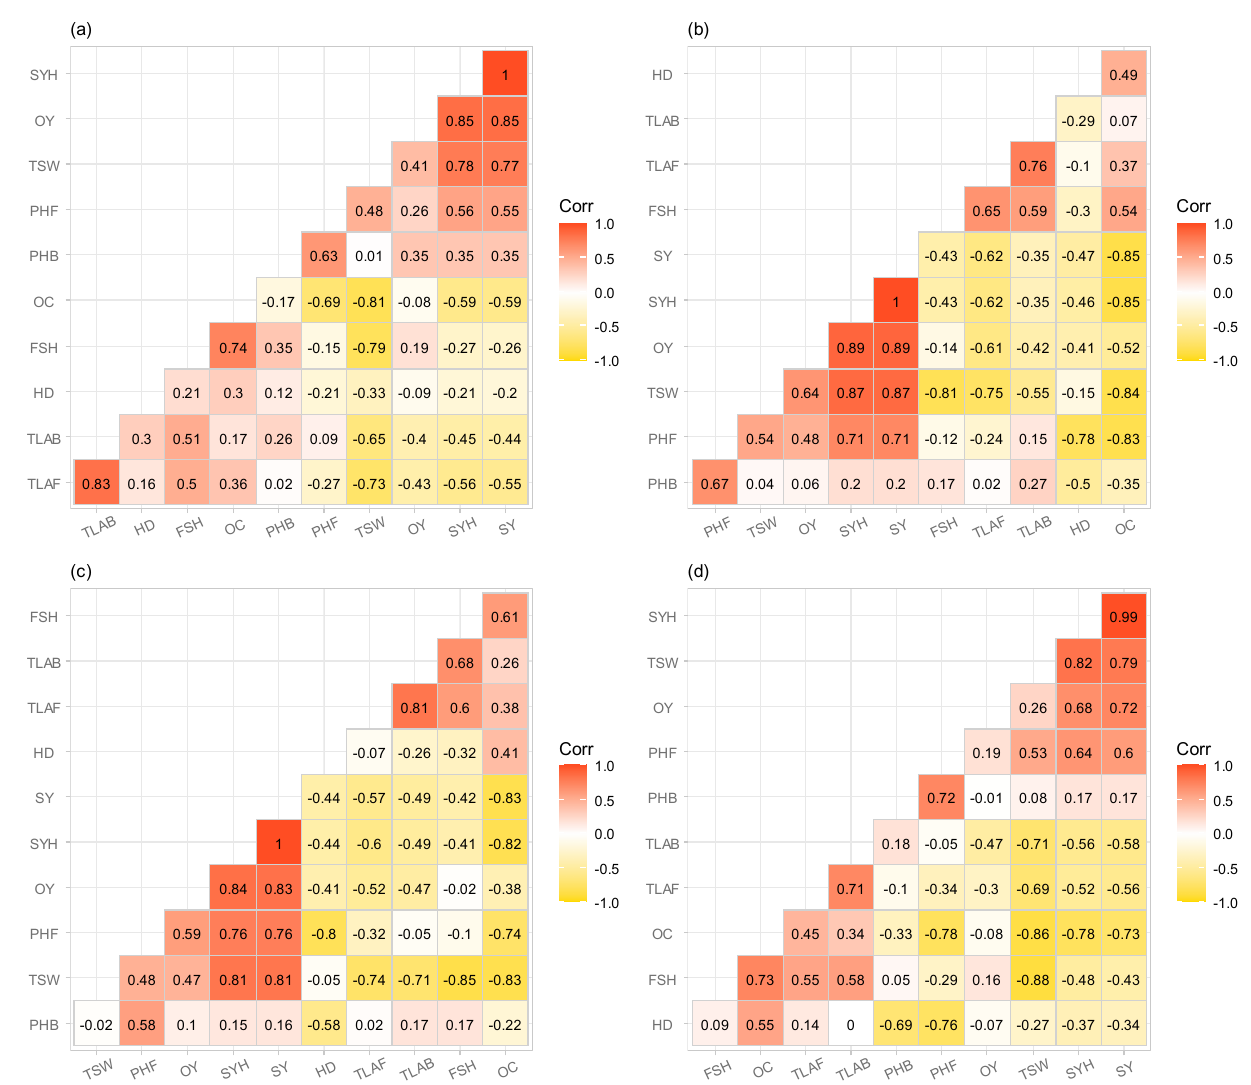
Figure 3. Heat map of sunflower trait correlations (average of all three hybrids); correlation thresholds: 0.05 = 0.576, 0.001 = 0.708; ( a ) sunflower × common vetch intercrop; ( b ) sunflower × red clover intercrop; ( c ) sunflower × alfalfa intercrop; ( d ) sunflower sole cropping; the magnitude of the correlation is denoted with a colour, whereby red indicates a positive correlation and yellow denotes a negative correlation. The stronger the correlation, the darker is the colour; HD-head diameter; OC-oil content; PHB-plant height in bud phase; PHF-plant height in flowering; SY-seed yield; TLAF-total leaf area per plant in flowering; TSW-thousand seed weight; NFSH-number of full seeds per head; OY-oil yield; SYH-seed yield per head; TLAB-total leaf area per plant in the bud phase. Table 5. Bayesian Information Criteria statistics for Model 1 and